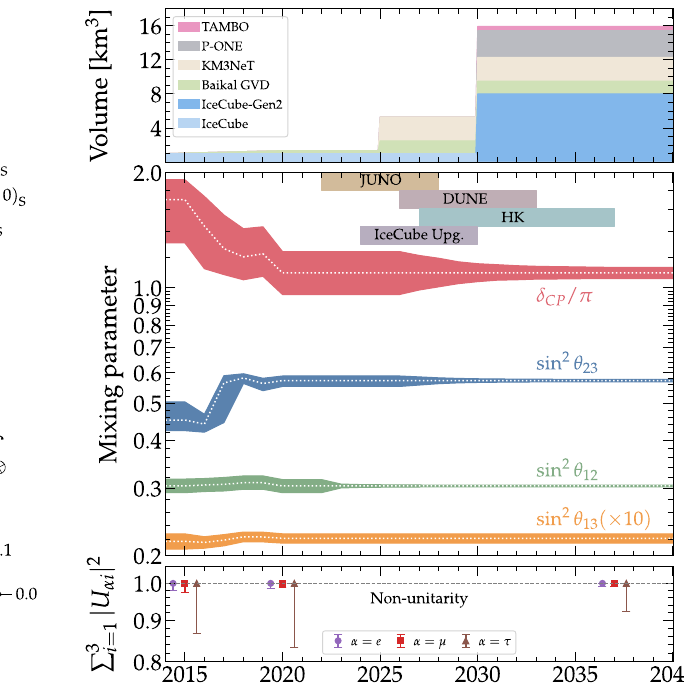
Fig. 17 Left: Flavor composition of astrophysical neutrinos at Earth now and in the future. Production scenarios are indicated by the differ- ent colors. The hue of the colors indicated the assumed uncertainties on the oscillation parameters: dark hues use the current uncertainties, while light hues use the expected uncertainties in 2040. Current con- straint on the flavor composition are shown in gray, while projections under different scenarios are shown in blue with different linestyles. Right: Evolution of high-energy neutrino telescopes volumes, neutrino